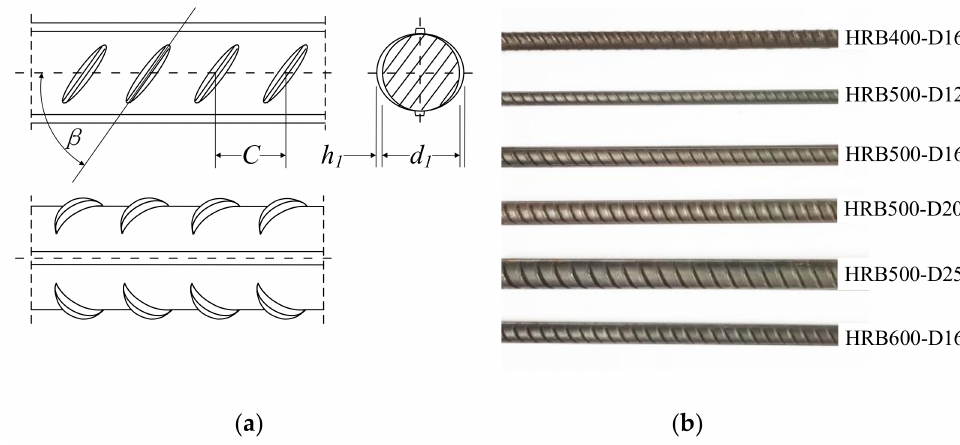
Figure 4. The surface configuration of deformed bars: ( a ) schematic diagram; ( b ) photo of deformed bars. Table 5. Geometric and mechanical properties of steel